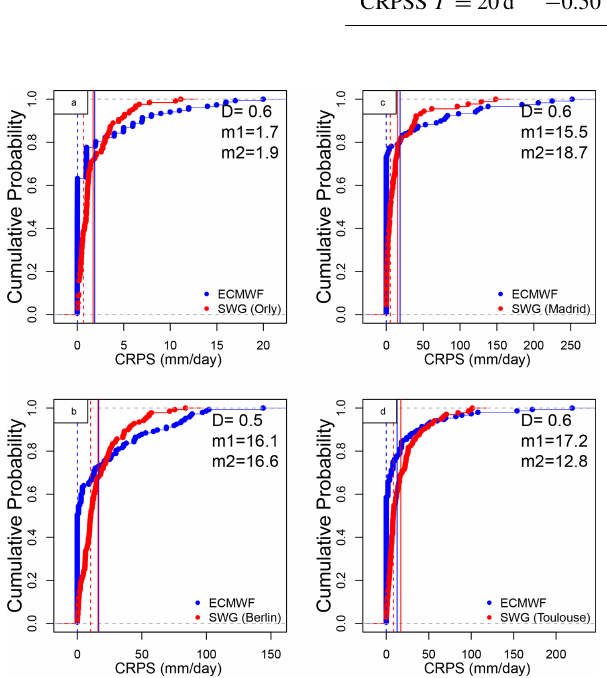
Figure 7. Empirical cumulative distribution function of the CRPS of ECMWF (blue) and SWG (red) forecasts for 5d, for Orly (a) , Berlin (b) , Madrid (c) , and Toulouse (d) . D is the maximum dis- tance between both ECDFs (value of Kolmogorov–Smirnov test). m 1 is the value of the time average of CRPS of SWG and m 2 is the value of the time average of CRPS of ECMWF. The dashed vertical lines represent the median of CRPS of ECMWF (blue) and SWG